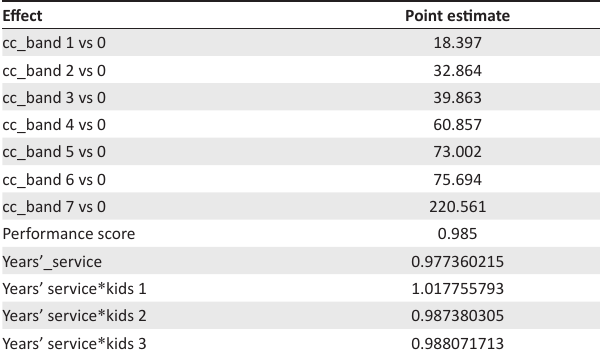
TABLE 6: Odds estimate ratio. TABLE 7: Effect of number of children on years of